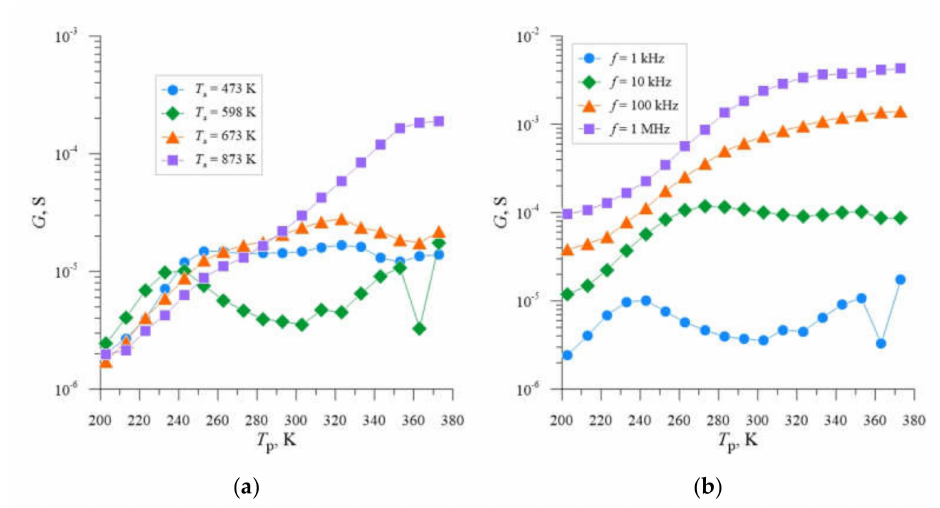
Figure 5. Dependencies G = f( T p ) for silicon with resistivity ρ = 0.4 Ω cm, boron-doped, implanted with Ne + neon ions with energy E = 100 keV and dose D = 4.0 × 10 14 cm − 2 , determined for the frequency f = 1 kHz and four different annealing temperatures T a ( a ) and annealing temperature T a = 598 K and four different measurement frequencies f ( b ).